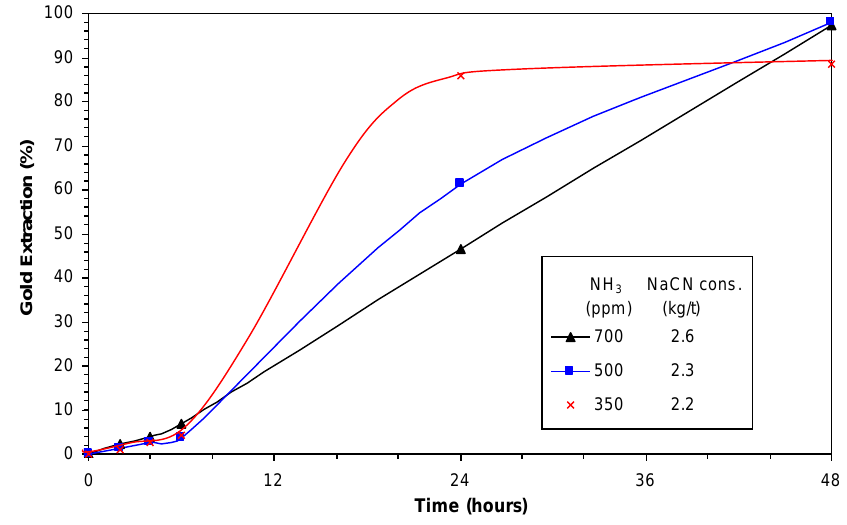
Figure 2. Effect of NaCN:NH ratio on gold leaching in presence of djurleite; 0.3% Cu, 3 400 ppm NaCN, pH 11.5–11.8, 8 ppm